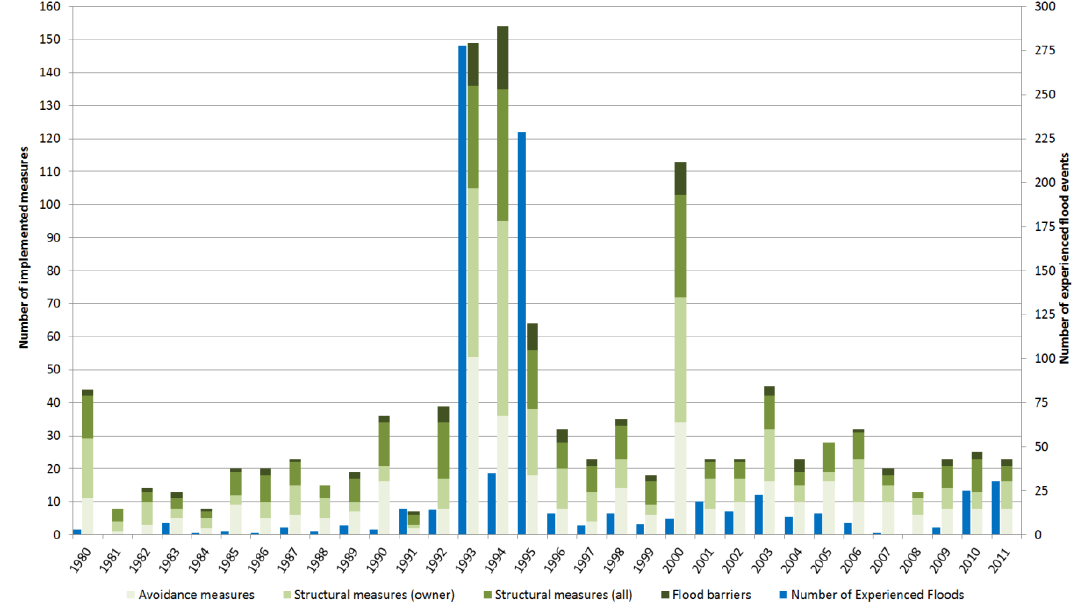
Fig. 1. Long-term development of the implementation of four types of flood mitigation measures by flood-prone households ( n = 752) along the German part of the Rhine